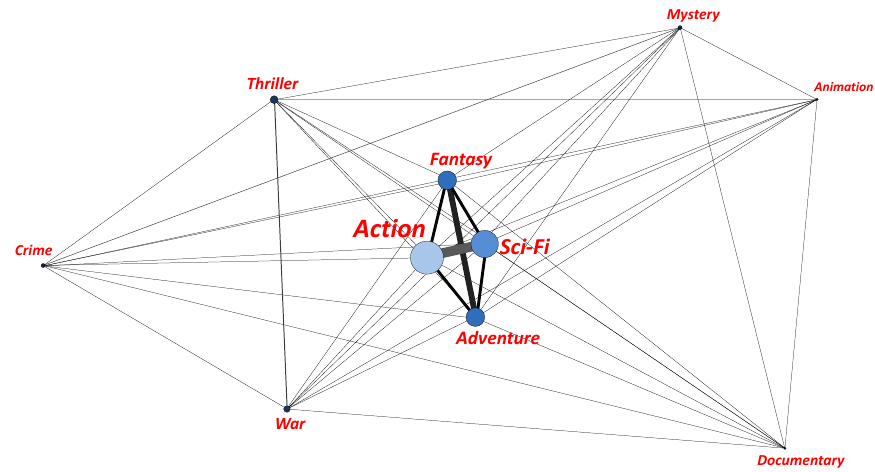
Figure 2. Conceptual visualization of a graph (node: circle radius, edge: line